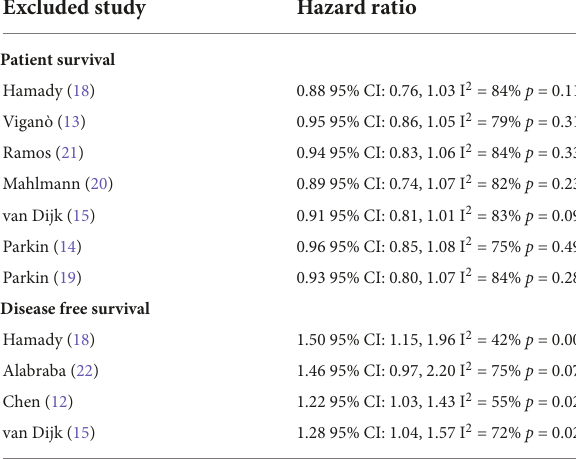
TABLE 3 Results of sensitivity